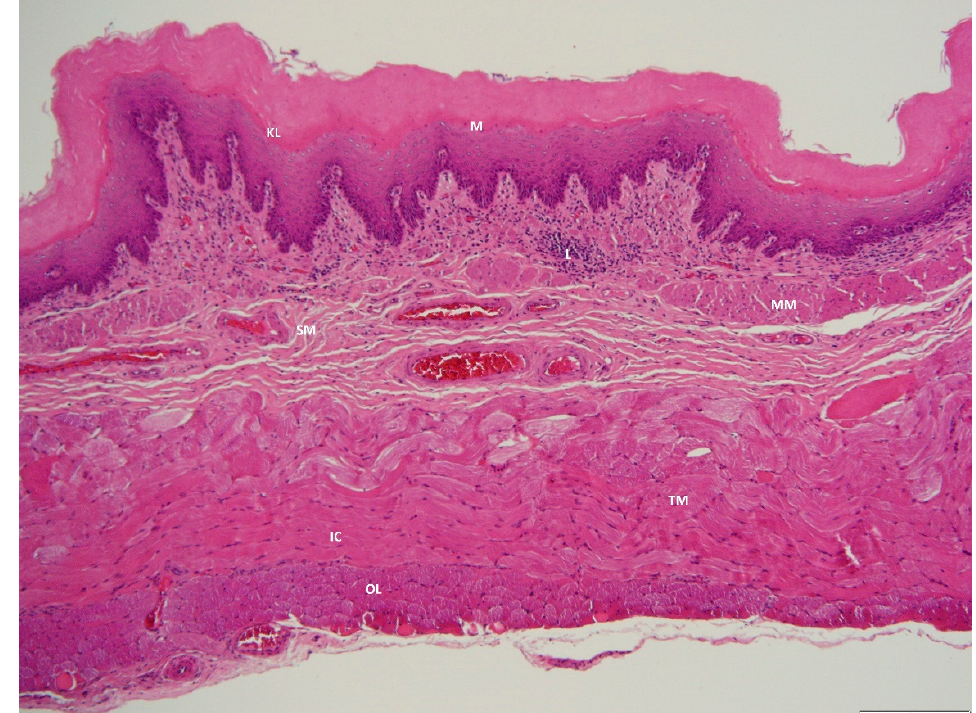
Figure 4. Photomicrograph of a transverse section through the esophagus of an adult male D. leporina